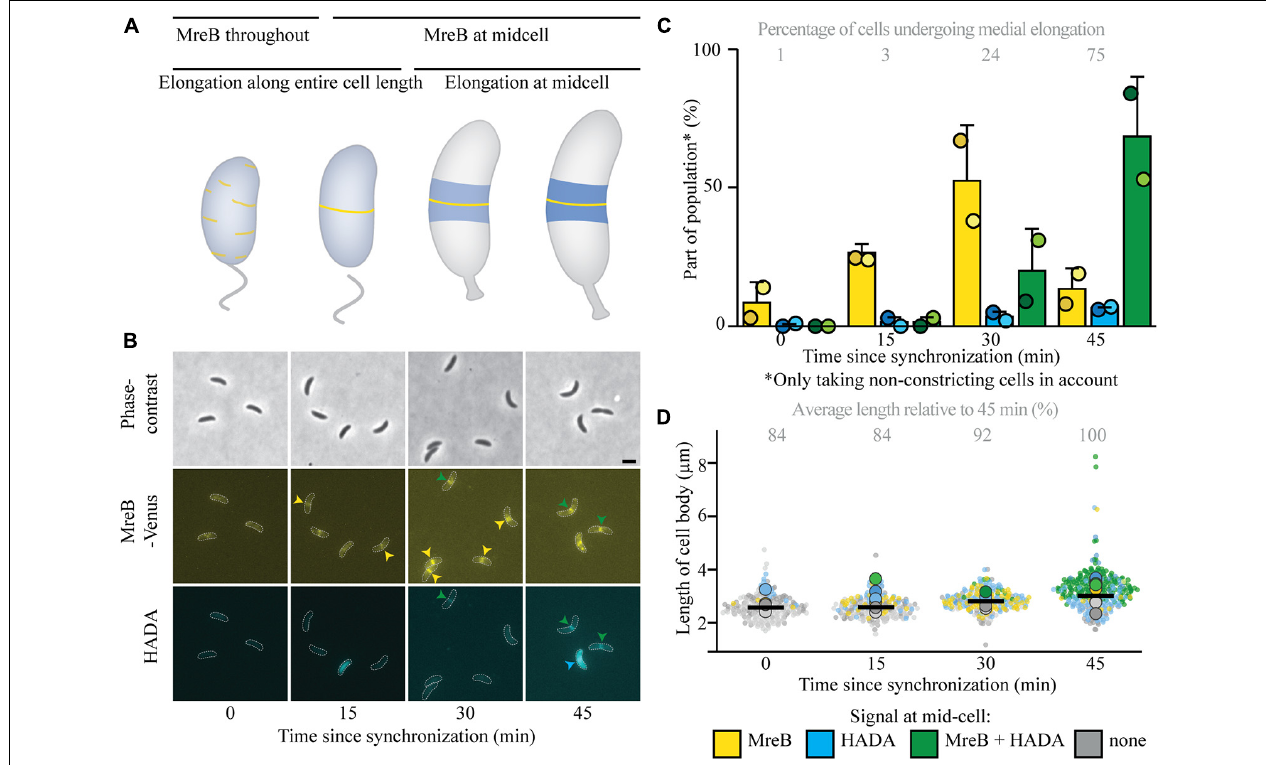
FIGURE 1 | MreB accumulates at midcell clearly before elongation at midcell commences. Intracellular localization of MreB (yellow) and peptidoglycan insertion and remodeling (blue) summarized in a cartoon (A) , based on the experiments shown in (B–D) . Light microscopy images (B) and respective quantification (C) of strain MT309 (P xyl - venus-mreB ) grown for the indicated duration after synchronization, stained with a short pulse of HADA show that with time MreB accumulates at midcell and cell wall remodeling at midcell commences with a delay. Cells in the representative images (B) are outlined and midcell localization is indicated by arrowheads: colocalizing MreB and HADA are indicated in green, only MreB in yellow, and only HADA in blue. Quantification of fluorescence signals (C) at midcell (using the color scheme outlined above) was performed on 100 non-constricting cells per replicate for two replicates per timepoint (value for each replicate is indicated by circles, replicate 1 is shown in a darker shade and replicate 2 in a light shade). Bars indicate the average of two replicates and error bars indicate standard deviation. In addition, the average percentage of non-constricting cells showing HADA (either in presence or absence of MreB) is given for each timepoint. Analysis of the length of cell bodies (of both constricting and non-constricting cells, in total at least 100 cells per replicate) shows that cells become longer with time and cells that are incorporating HADA are relatively longer (D) . Cell lengths are shown in superplots, where each small dot indicates the value for a single cell. The color of each dot follows the color scheme outlined above, in order to identify differences in cell length for the different subpopulations, and shows different shades to differentiate between the replicates. The large dots show the average cell length for each localization subpopulation per replicate. The horizontal black bar indicates the average length over all cells and the numbers above the graph express this average length as a percentage of the average length of the cells after 45